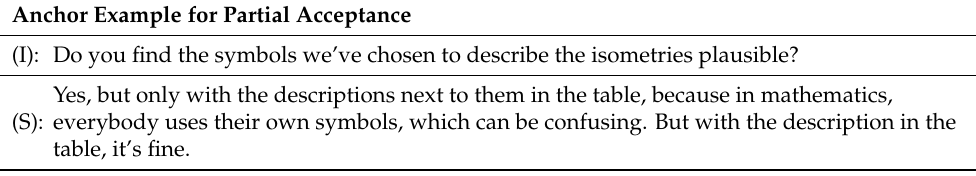
Table 5. Partial acceptance of Participant G and A1-2 (cf. Table A3 in the Appendix A). Anchor Example for Partial